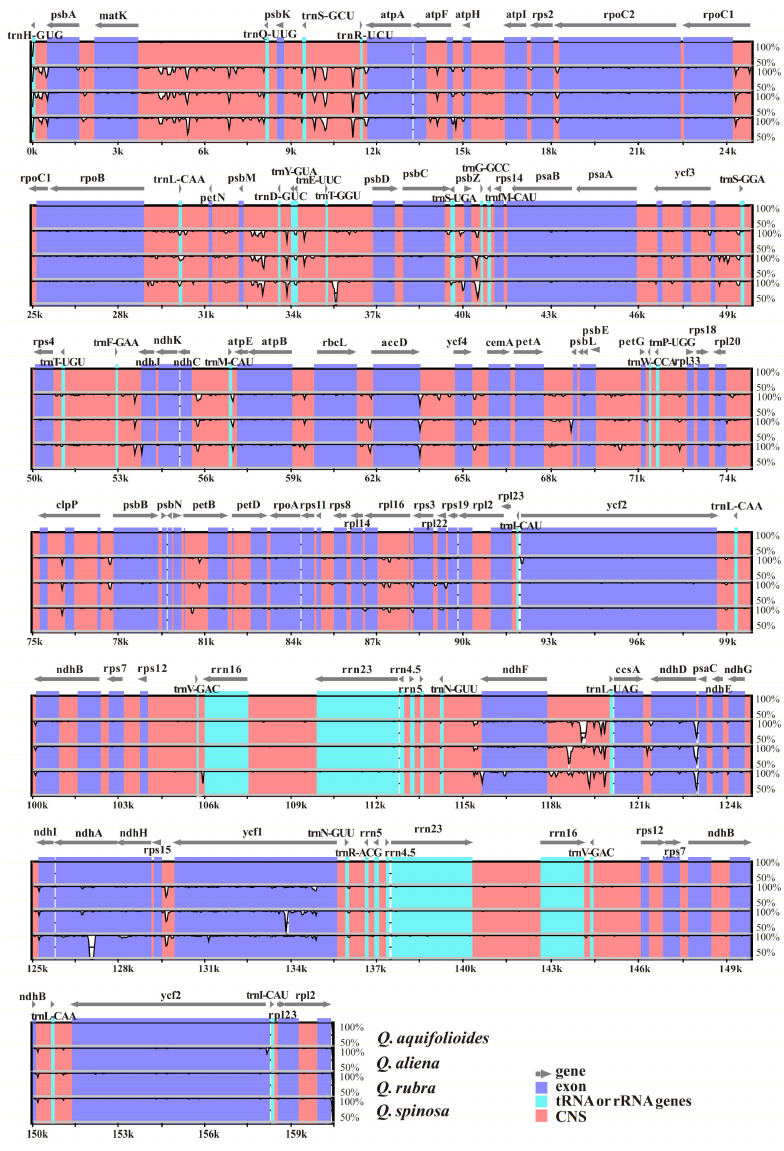
Figure 6. Alignment of four Quercus cp genome sequences. Sequence identity plot for four Quercus species, with Q. aquifolioides as a reference. The X -axis corresponds to coordinates within the cp genome. The Y -axis shows the percentage identity in the range 50% to